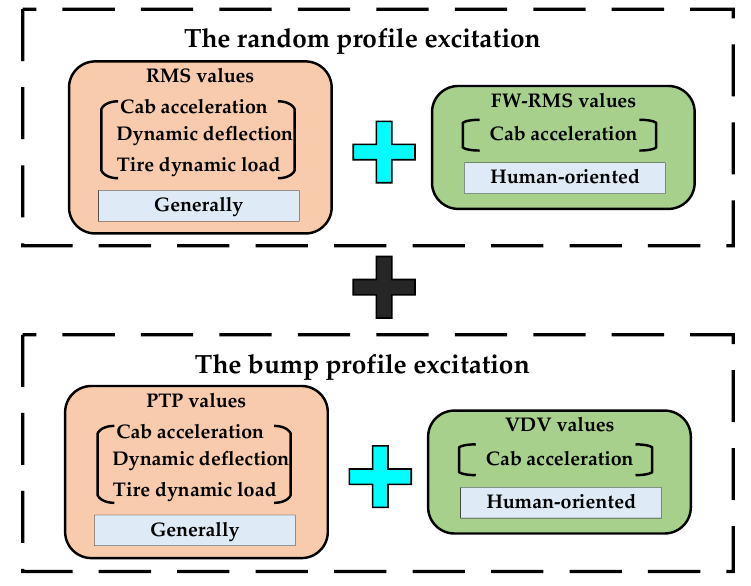
Figure 10. The evaluation process.